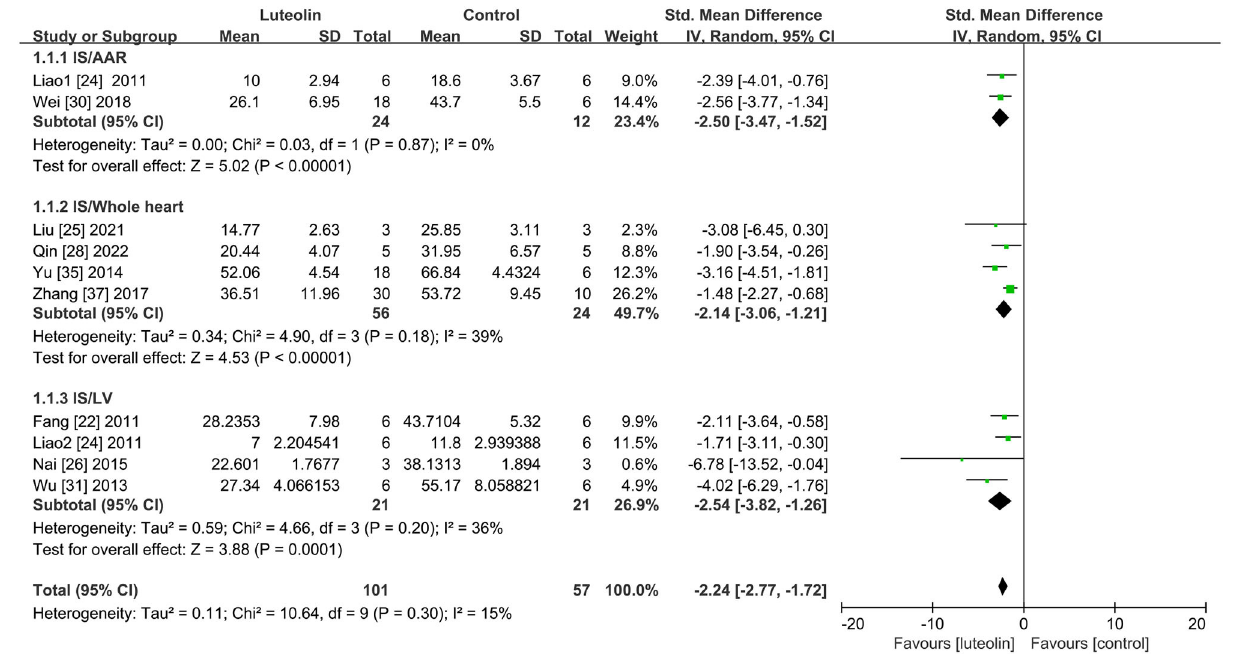
Frontiers in Cardiovascular Medicine |